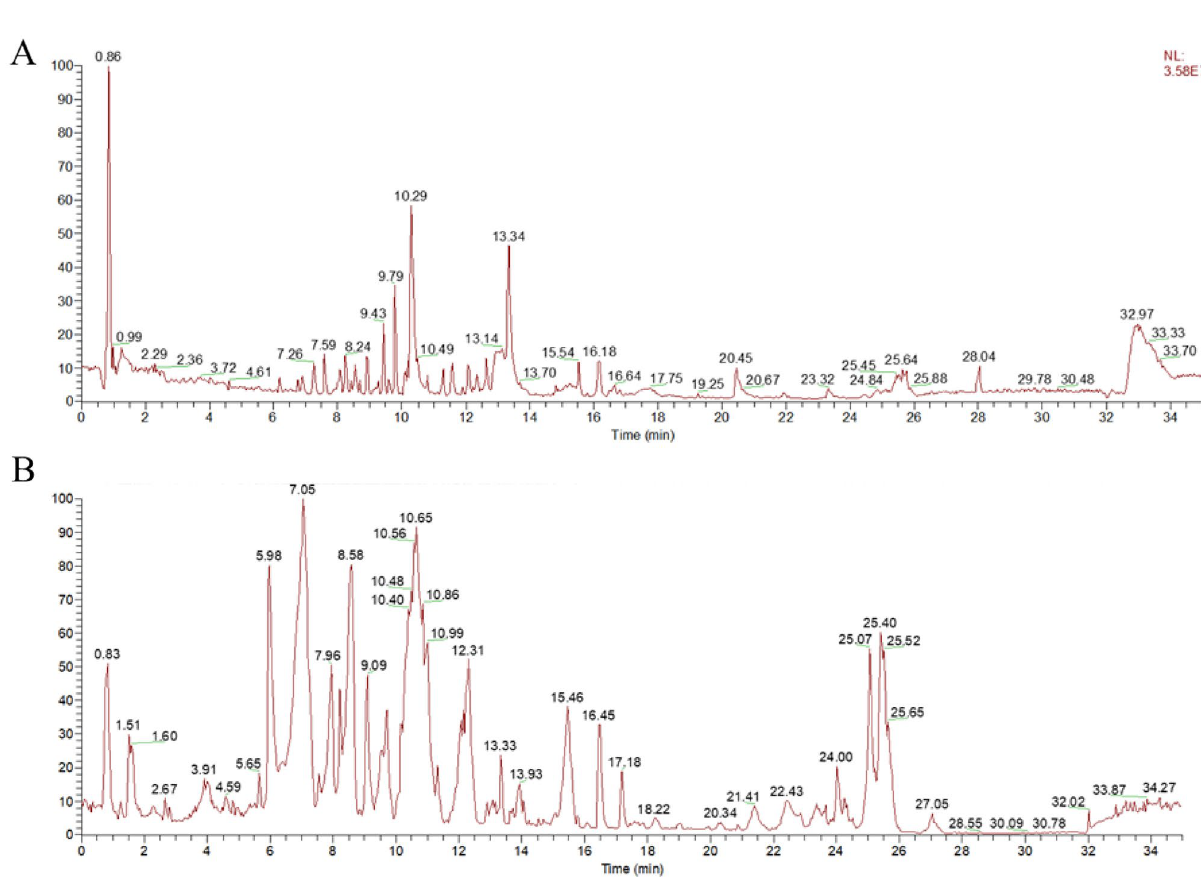
Figure 2. Total ion flow diagram of cinnamon aqueous extract in positive ( A ) and negative ( B ) ion